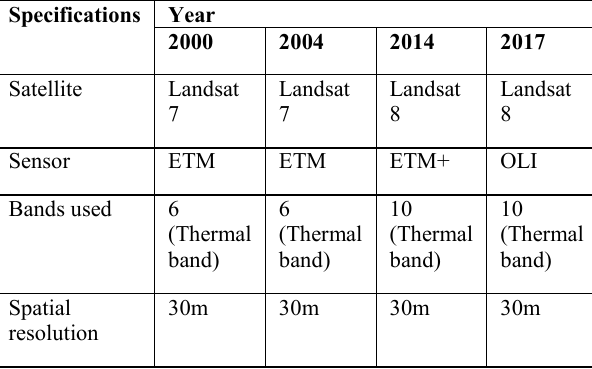
Table 3 Details of satellite data for LST calculation